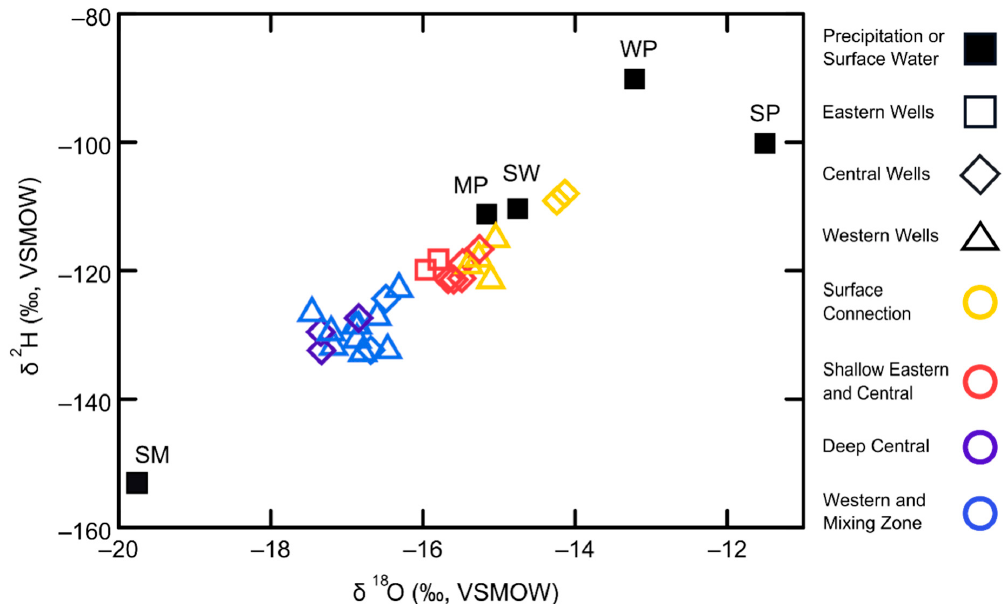
Figure 4. Measured and modeled values of δ 18 O and δ 2 H for precipitation, surface water and groundwater in the South Fork Palouse River Basin. Measured values for summer (SP) and winter (WP) precipitation from USNIP station WA24, near Pullman, Washington, are plotted as weighted averages. Also included are published values for surface water (SW), analyzed values for snow (SM) atop the Palouse Range and modeled values for precipitation (MP) from atop the Palouse Range.